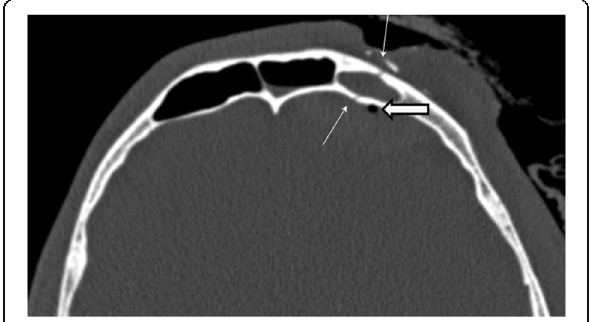
Fig. 14 Frontal sinus fracture. Axial unenhanced CT image of the frontal bone demonstrates a nondisplaced fracture of the anterior and posterior walls (thin arrows) of the left frontal sinus, with partial opacification of the frontal sinus and small foci of pneumocephalus (thick